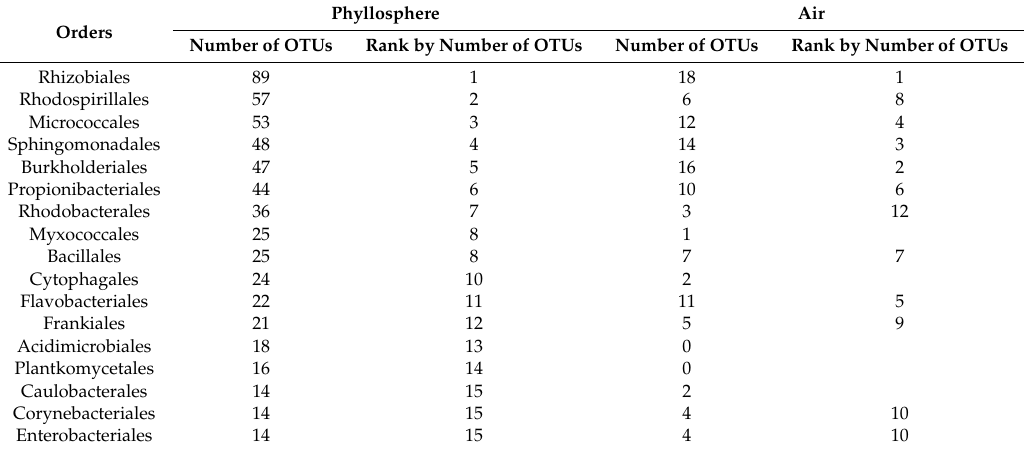
Table 4. The first fifteen orders of phyllosphere bacteria ranked in descending order by the number of OTUs detected in the phyllosphere of the Mediterranean ecosystem studied that belong to them.